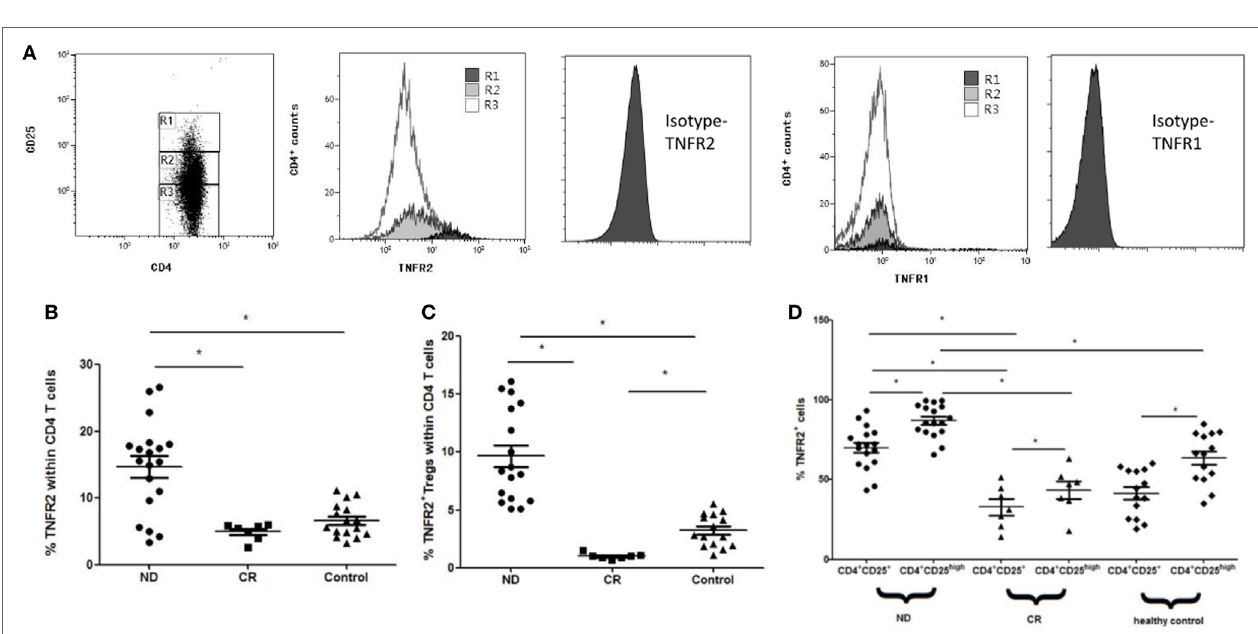
FigUre 4 | Comparison of CD4 + CD25 + and CD4 + CD25 high T cells in total CD4 + T cells from acute myeloid leukemia (AML) patients and healthy controls. (a) The frequency of CD4 + CD25 high regulatory T cell (Treg) was determined as the percentage of brighter CD25 + cells on gated CD4 + T cells (based on forward and side scatter and CD4 staining). Isotype for CD25 was also performed. (B) CD4 + CD25 + Foxp3 + Tregs in the newly diagnosed (ND) AML patients were higher than that in controls. Representative flow plots of ND and controls were also